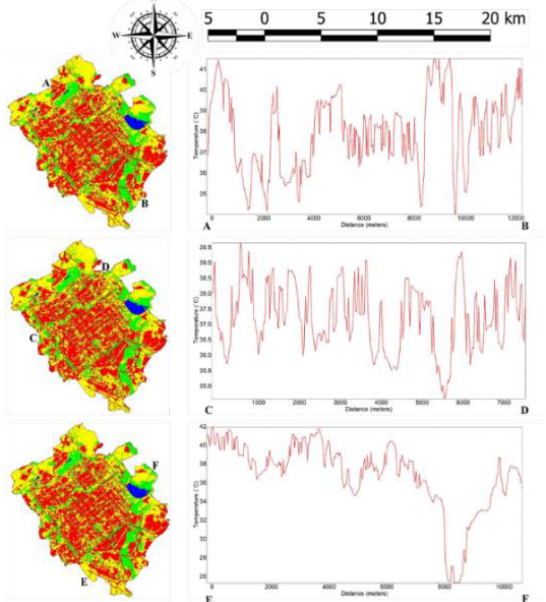
Figure 8: Temperature profile graph for Chandigarh